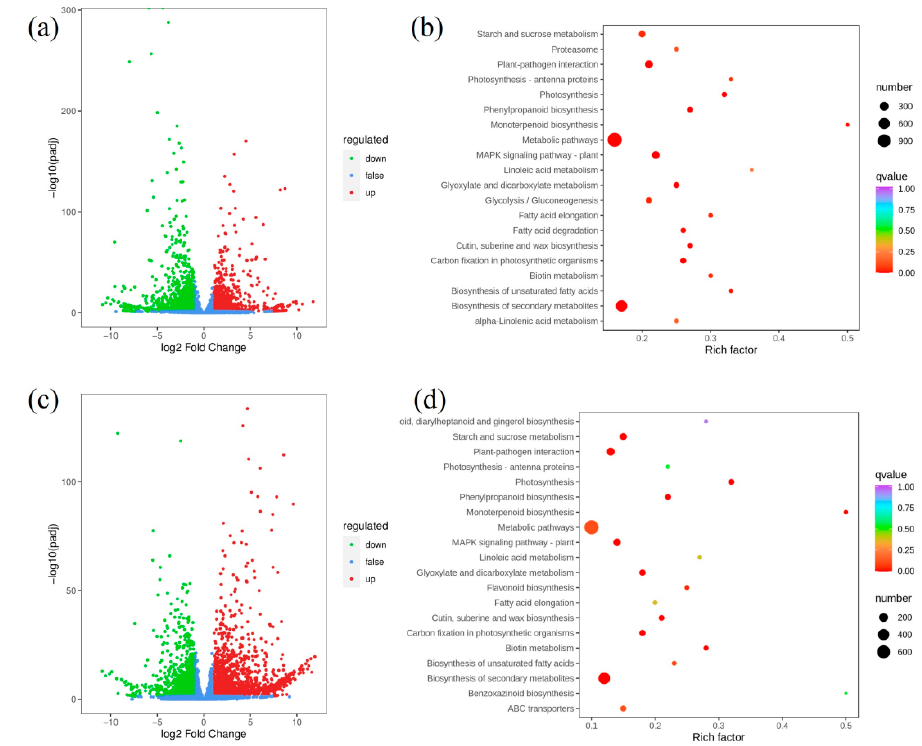
Figure 5. Enrichment analysis of differentially expressed genes. ( a , c ) Treatment with 0H light, the volcano map and KEGG enrichment analysis between wild type and sub-1 mutant. ( b , d ) Treatment with 16H light, the volcano map and KEGG enrichment analysis between wild type and the sub-1 mutant.